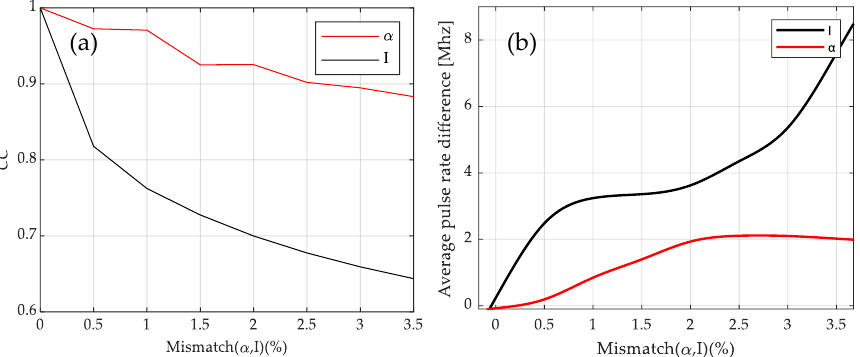
Figure 9. Effect of external parameter mismatch on ( a ) the correlation coefficient and ( b ) the difference of the average spike rate.